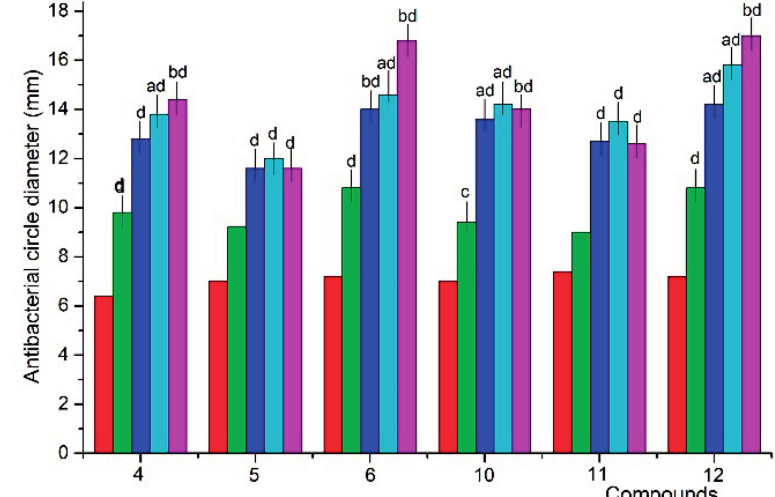
Figure 4. Antibacterial circle for compounds 4 , 5 , 6 , 10 , 11 , and 12 ; a: compared with 4 , p < 0.05; b: compared with 4 , p < 0.01; c: compared with hay bacillus, p < 0.05; d: compared with hay bacillus, p < 0.01; ad: compared with 4 , p < 0.05, and compared with Bacillus p < 0.01; bd: compared with 4 , p < 0.01, and compared with Bacillus p < 0.01. Red column: hay bacillus; green column: Staphylococcus aureus ; blue column: colon bacillus; light blue: typhoid bacillus; pink column: Pseudomonas aeruginosa